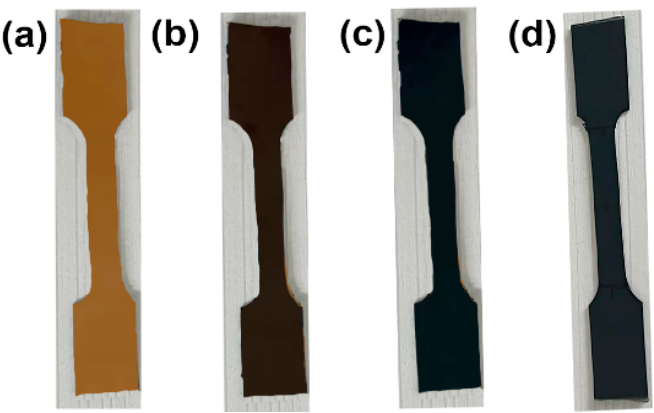
Figure 3. Digital images of mechanical samples of ( a ) HDPE 0.7 wt.% Cu-NCs, ( b ) HDPE 0.5 wt.% Cu-NPs, ( c ) rHDPE 0.7 wt.% Cu-NCs, and ( d ) rHDPE 0.5 wt.% Cu-PCs. Cu-NPs, ( c ) rHDPE 0.7 wt.% Cu-NCs, and ( d ) rHDPE 0.5 wt.%